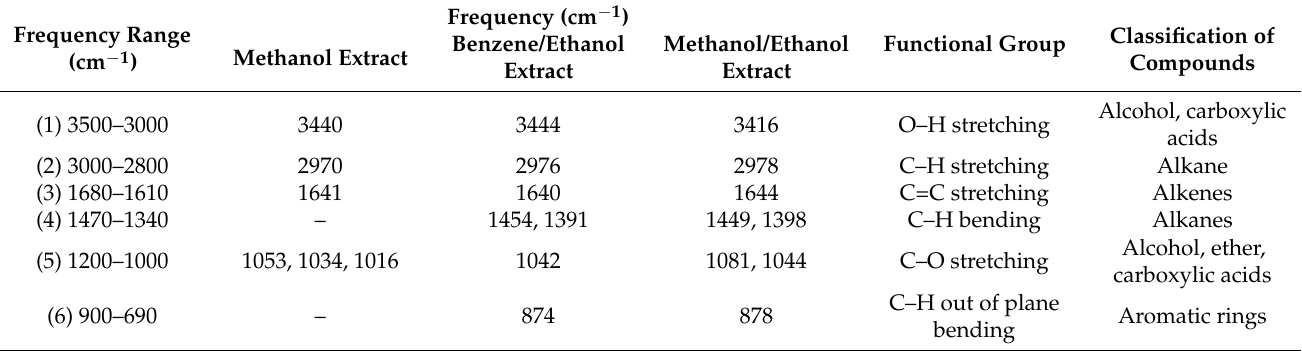
Figure 1. FTIR spectra of S. holocarpa (methanol), S. holocarpa (benzene/ethanol), and S. holocarpa (ethanol/methanol) samples. Table 2. The functional group and classification of compounds obtained from S. holocarpa wood extracts.